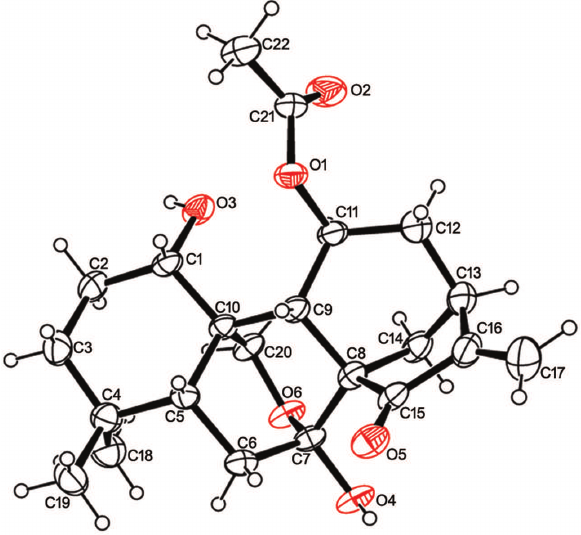
Table 1: Data collection and handling.